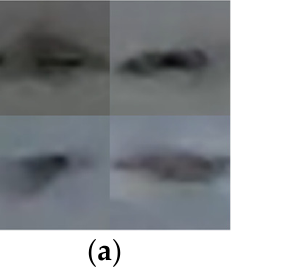
Figure 3. Comparison between DCGAN-generated scratch samples and original samples. ( a ) Real scratch samples. ( b ) Scratch samples generated by DCGAN.